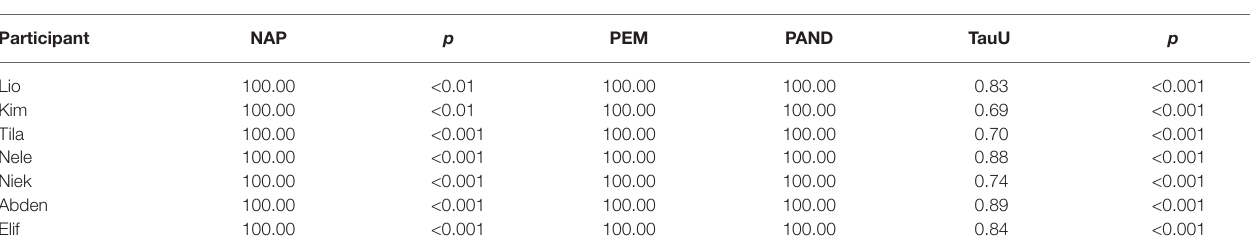
TABLE 3 | Overlap indices for expressive vocabulary.